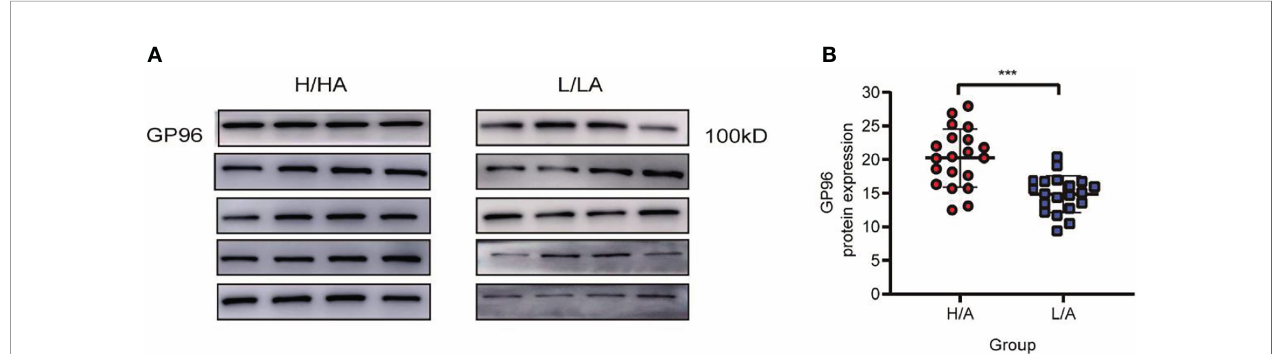
FIGURE 4 | The relative expression level of PDE-EVs-GP96. (A) Western blotting analysis of PDE-EVs-GP96 expression in the H/A and the L/A group. 50 µg of total protein from each sample was added to each well. (B) Concentration of PDE-EVs-GP96 in the H/A and the L/A group was measured by ELISA. All data were presented as means ± SEM. Statistical analysis was performed with an unpaired Student ’ s t -test. *** p < 0.001, n = 20 per group.